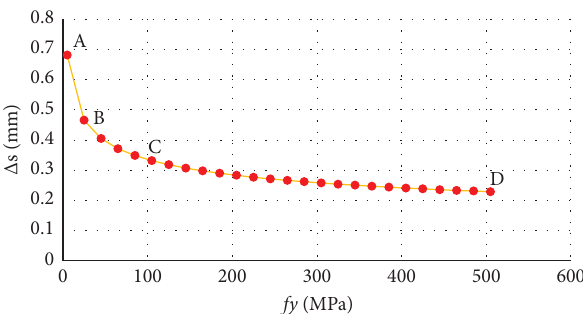
Figure 15: Te relationship between the bond-slip and the bond